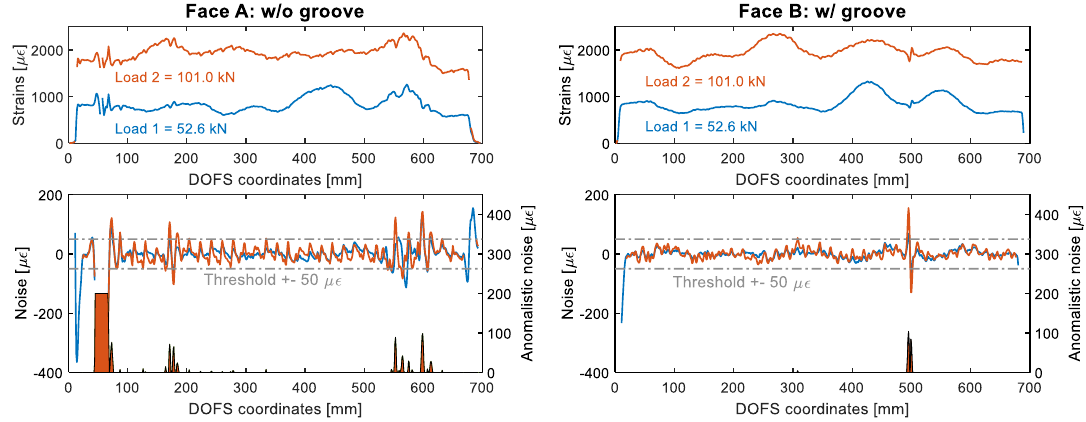
Figure 20. Member 8D16’s strain profiles ( top ) and noise level ( bottom ) study for strain reading anomalies (SRA) analysis.